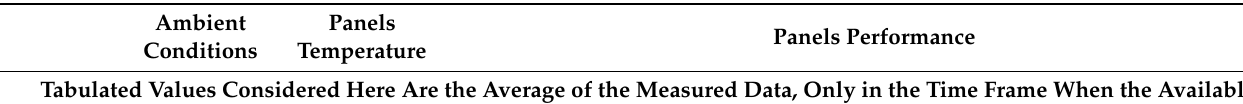
Table 1. Performance of the Panels at local ambient conditions @ 900 W/m 2 .